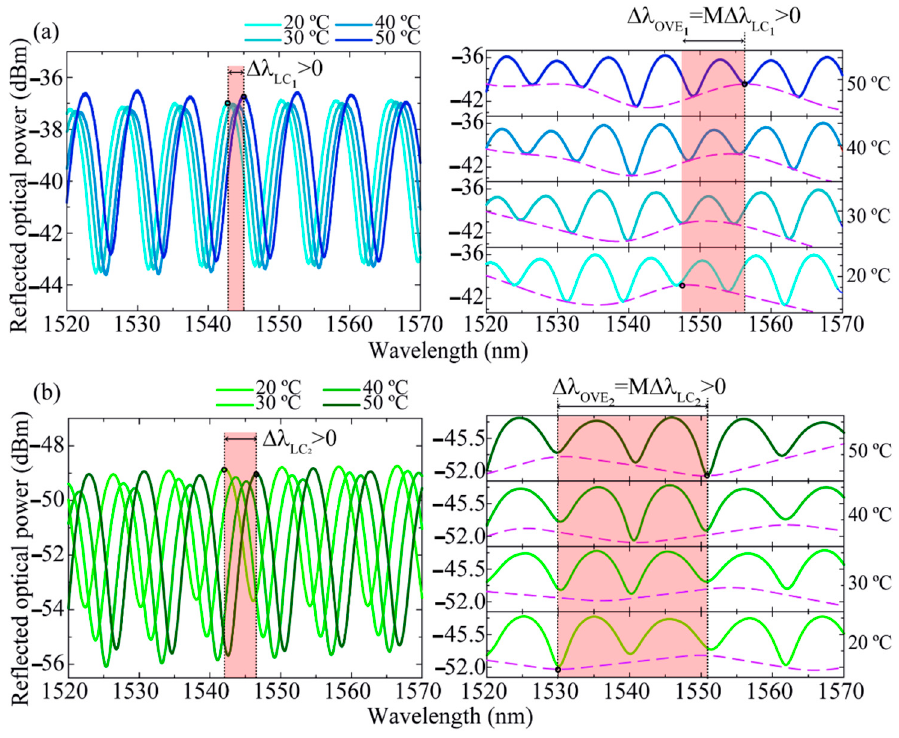
Figure 7. Spectra of ( a ) LC 1 /OVE 1 and ( b ) LC 2 /OVE 2 for four different temperature values. On the right, the purple dashed lines represent the lower envelopes of the OVE-based sensors. The peaks’ central wavelength shifts of LC 1 /LC 2 and OVE 1 /OVE 2 with temperature variations were monitored, resulting in the data presented in Figure 8.